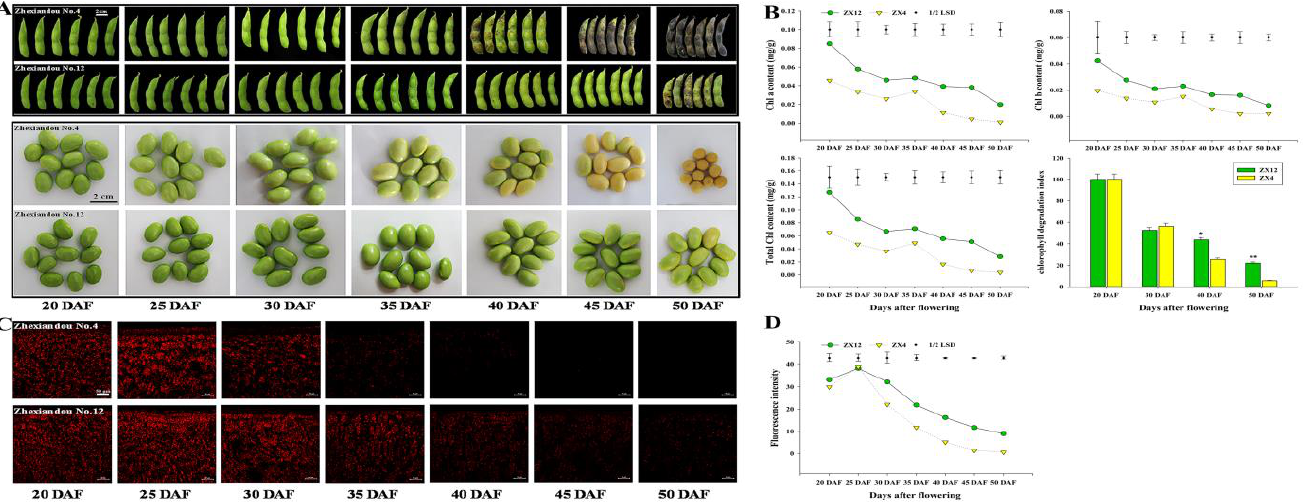
Figure 1. Chl content of soybean varieties ZX4 and ZX12. ( A ) Photographs of the phenotype of pods and seeds at different days (20 d, 25 d, 30 d, 35 d, 40 d, 45 d, and 50 d) after flowering. ( B ) Chl content (Chl a, Chl b, total Chl, and Rate of Chl degradation) of ZX4 and ZX12 seeds at different DAF. ( C ) Photographs of Chl autofluorescence intensity of ZX4 and ZX12 seeds at different DAF. ( D ) Chl fluorescence intensity of ZX4 and ZX12